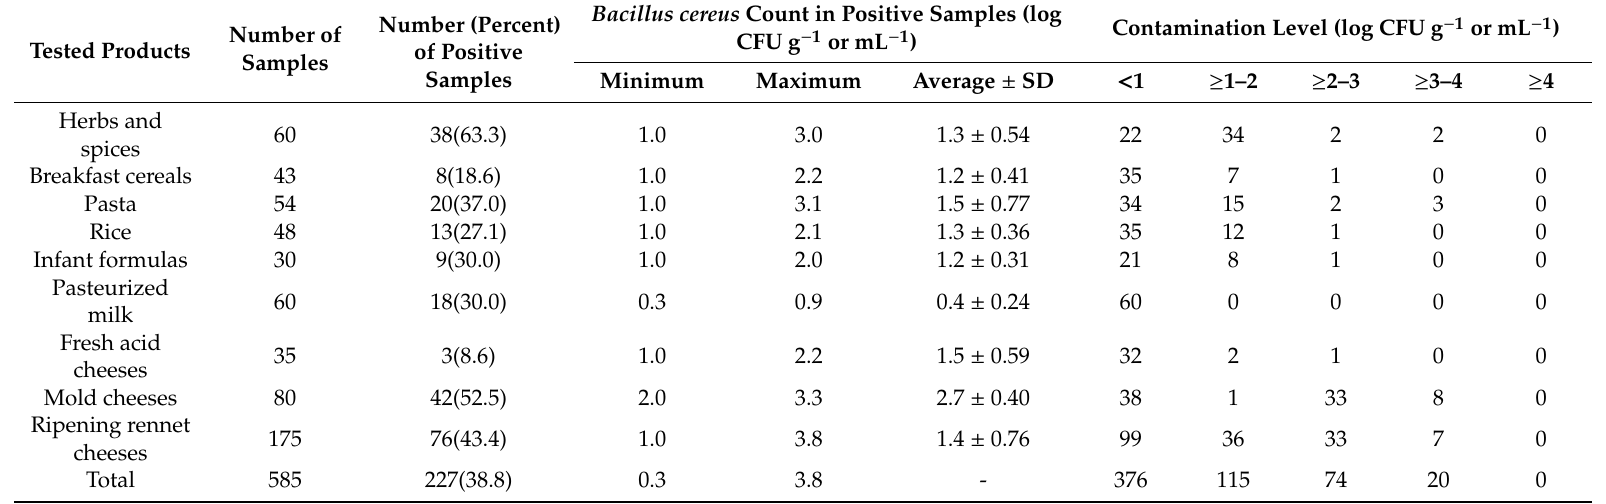
Table 1. The prevalence of Bacillus cereus in the commercial products